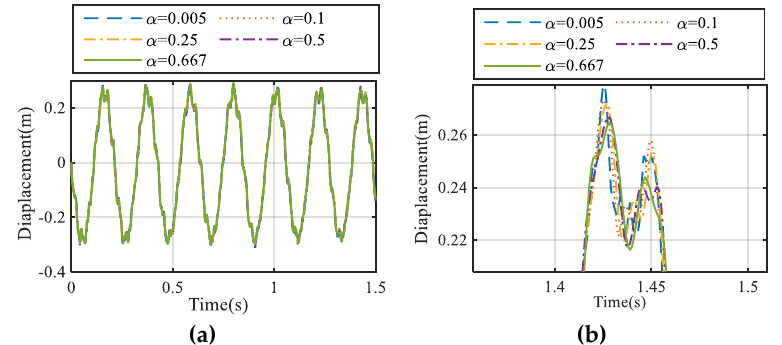
Figure 17. Displacement responses of Point A for various parameter α : ( a ) displacement responses from 0 to 1.5 s; ( b ) partial enlarged drawing of responses.